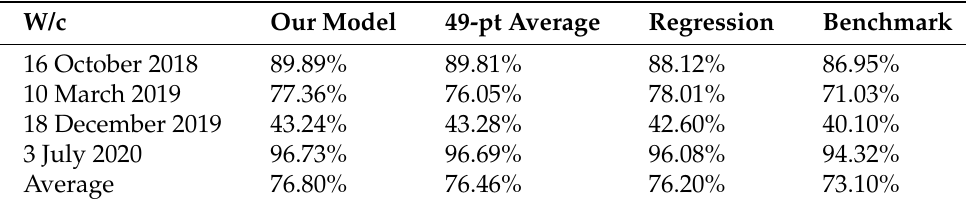
Table 2. Percentage charge dervied from PV based on charging profiles from four different models. Our model is based on combining an average for the time of year with a Bayesian regression of the forecast solar luminosity.